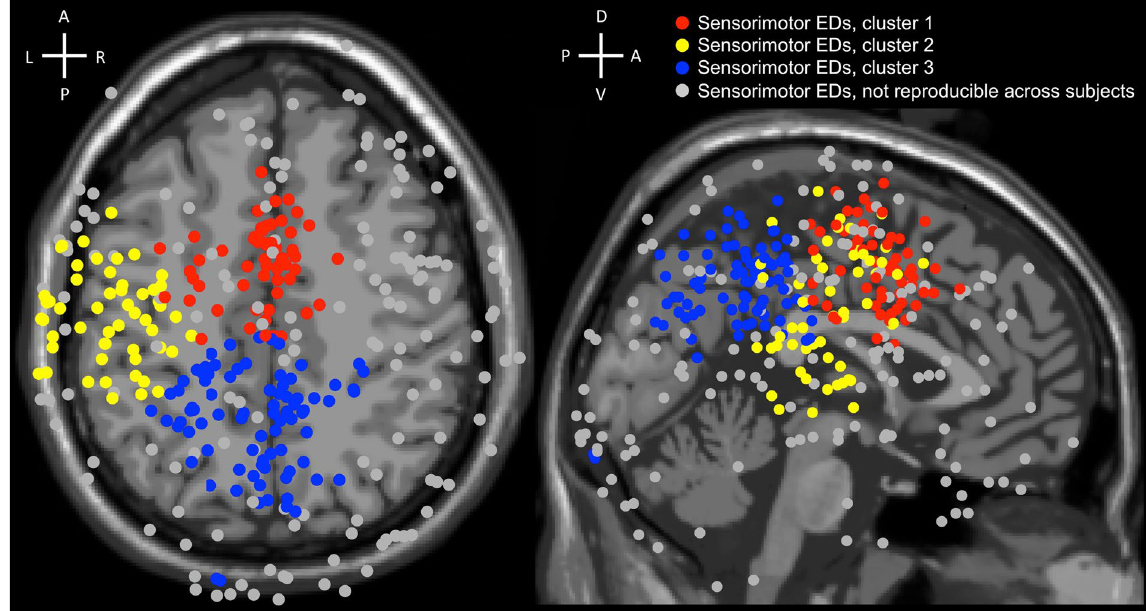
Figure 6. Three clusters (coloured in red, yellow, and blue) obtained by the k-means clustering algorithm from 192 Sensorimotor EDs reproducible across subjects from 32-, 64-, and 127-channel datasets. 151 Sensorimotor EDs, which were not reproducible across subjects, were coloured in grey and did not participate in the k-means clustering. Cluster 1 = Sensorimotor EDs coloured in red; Cluster 2 = Sensorimotor EDs coloured in yellow; Cluster 3 = Sensorimotor EDs coloured in blue. Labels at the crosses represent anterior (A), posterior (P), dorsal (D), ventral (V), left (L), and right (R)